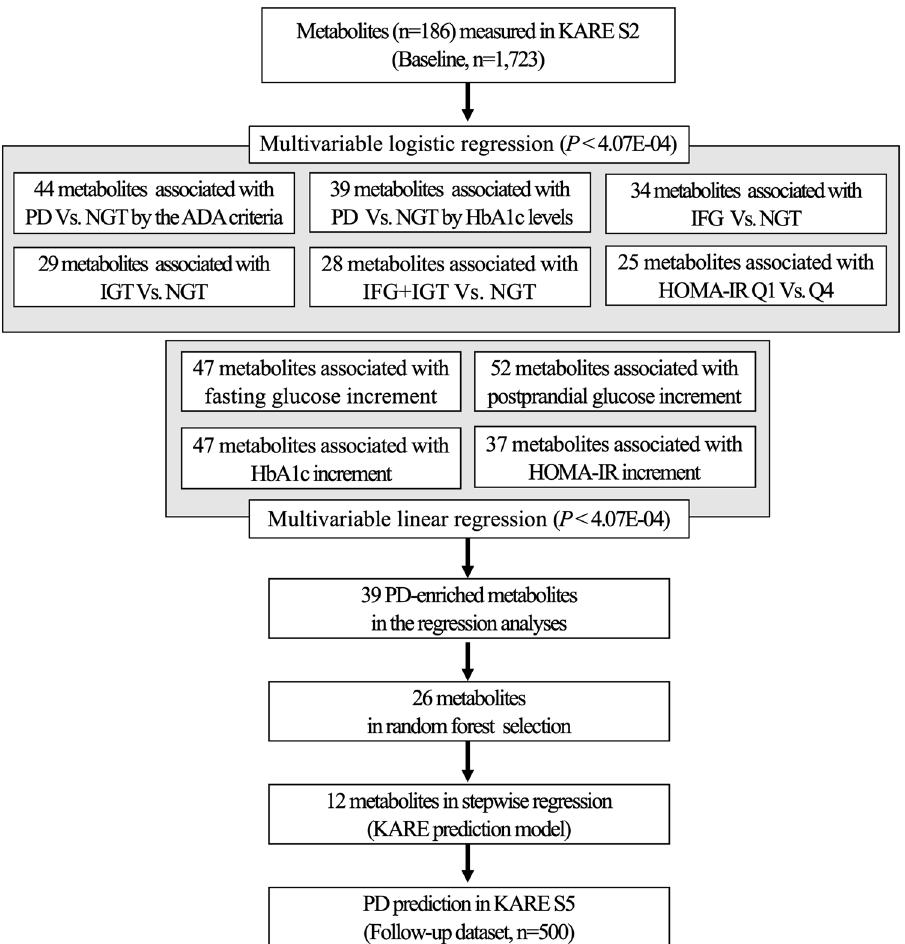
Figure 3. Flow chart of metabolite selection. The selected metabolites showed significant concentration differences in multivariable logistic and linear regression analysis with adjustment for age, sex, and BMI. The Bonferroni correction was applied for multiple testing with P < 4.07E−04. KARE S2/S5 Korea Association REsource (KARE) cohort 2nd Survey/5th Survey, PD Prediabetes, ADA American Diabetes